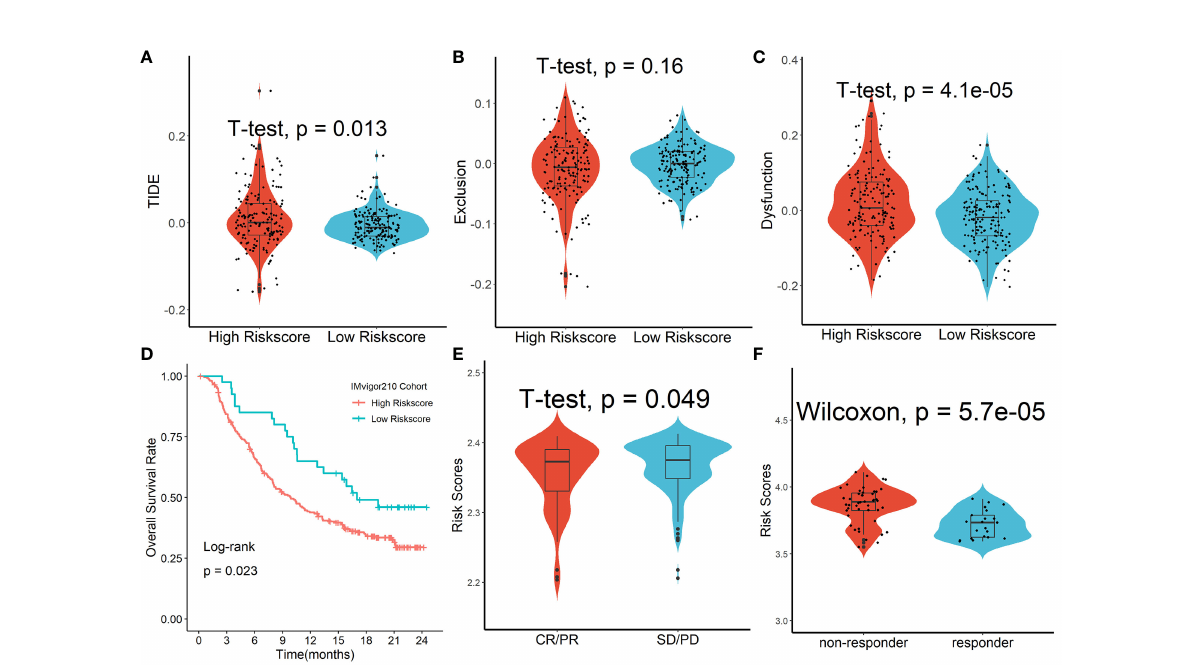
FIGURE 9 Forecasting response to anti-PD-L1 therapy using the Tregs-related signature. (A) TIDE scores in the high-risk scores group were much greater than that in the low-risk scores group. (B) T-cell exclusion scores did not differ signi fi cantly between the two groups. (C) T-cell dysfunction scores were greater in the high-risk scores group than in the low-risk scores group. (D) Patients with low risk ratings had a signi fi cant survival advantage over those with high risk scores. (E) Patients who had a complete response/partial response (CR/PR) had lower risk scores than patients who had stable disease/progressive disease (SD/PD). (F) Patients in the high-risk scores group had worse Sorafenib treatment ef fi